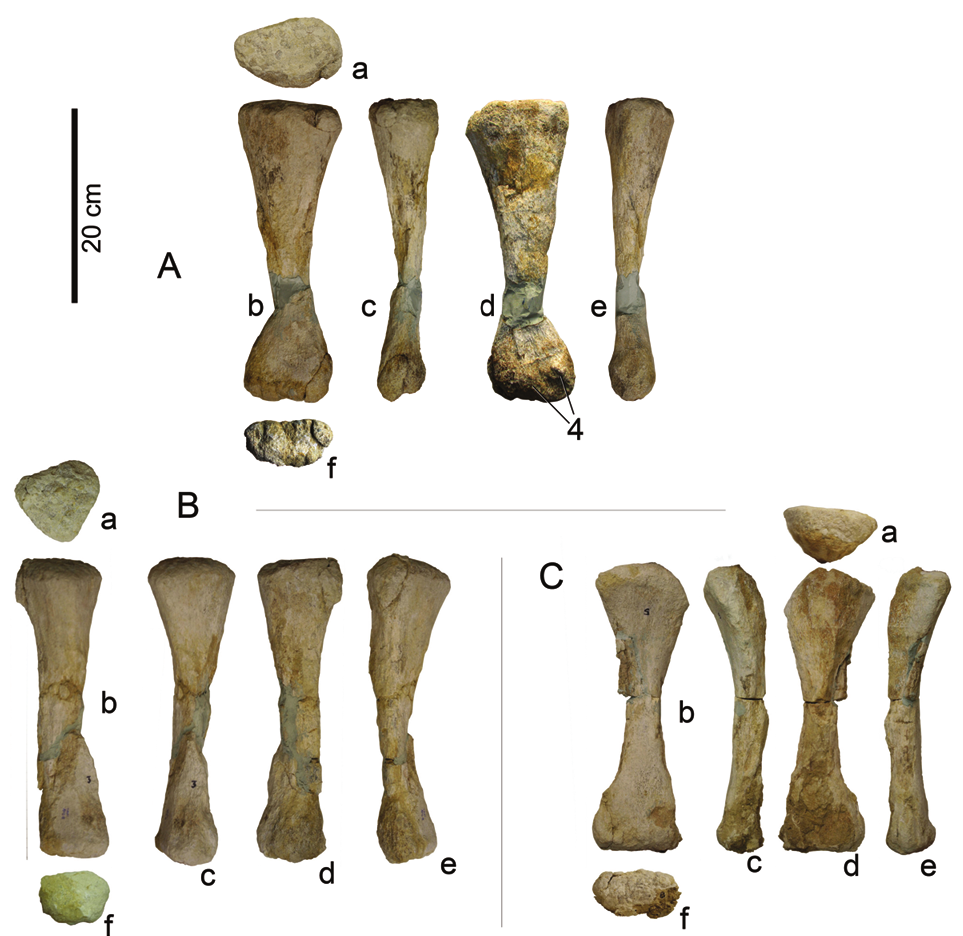
Fig. 5 – Angolatitan adamastor n. gen. et sp., right metacarpals I (A), III (B) and IV (C), in proximal (a), anterior (b), medial (c), palmar (d), lateral (e), and distal (f) views. 4, posterior facet of the distal epiphysis of metacarpal I has two small splint-like projections